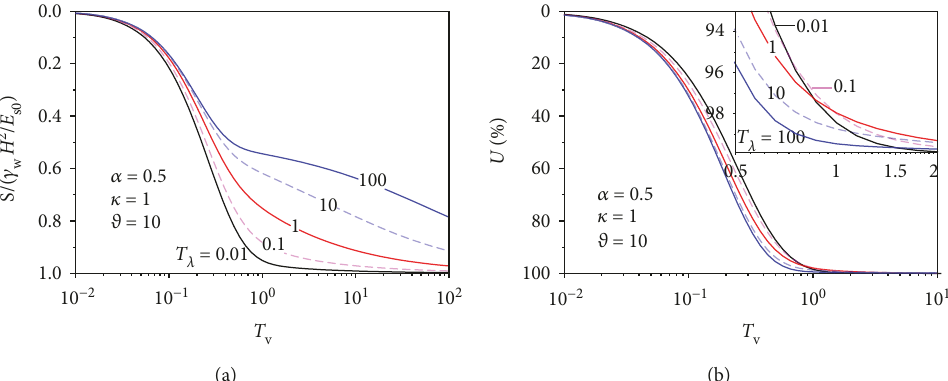
Figure 5: In fl uence of the creep time factor on the consolidation behavior of the aquifer system. (a) Settlement of aquitard. (b) Degree of consolidation.